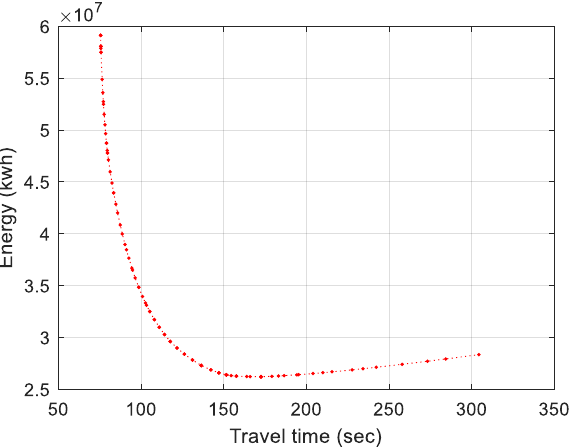
Figure 4. Pareto curve for multiple weights between energy consumption versus time.